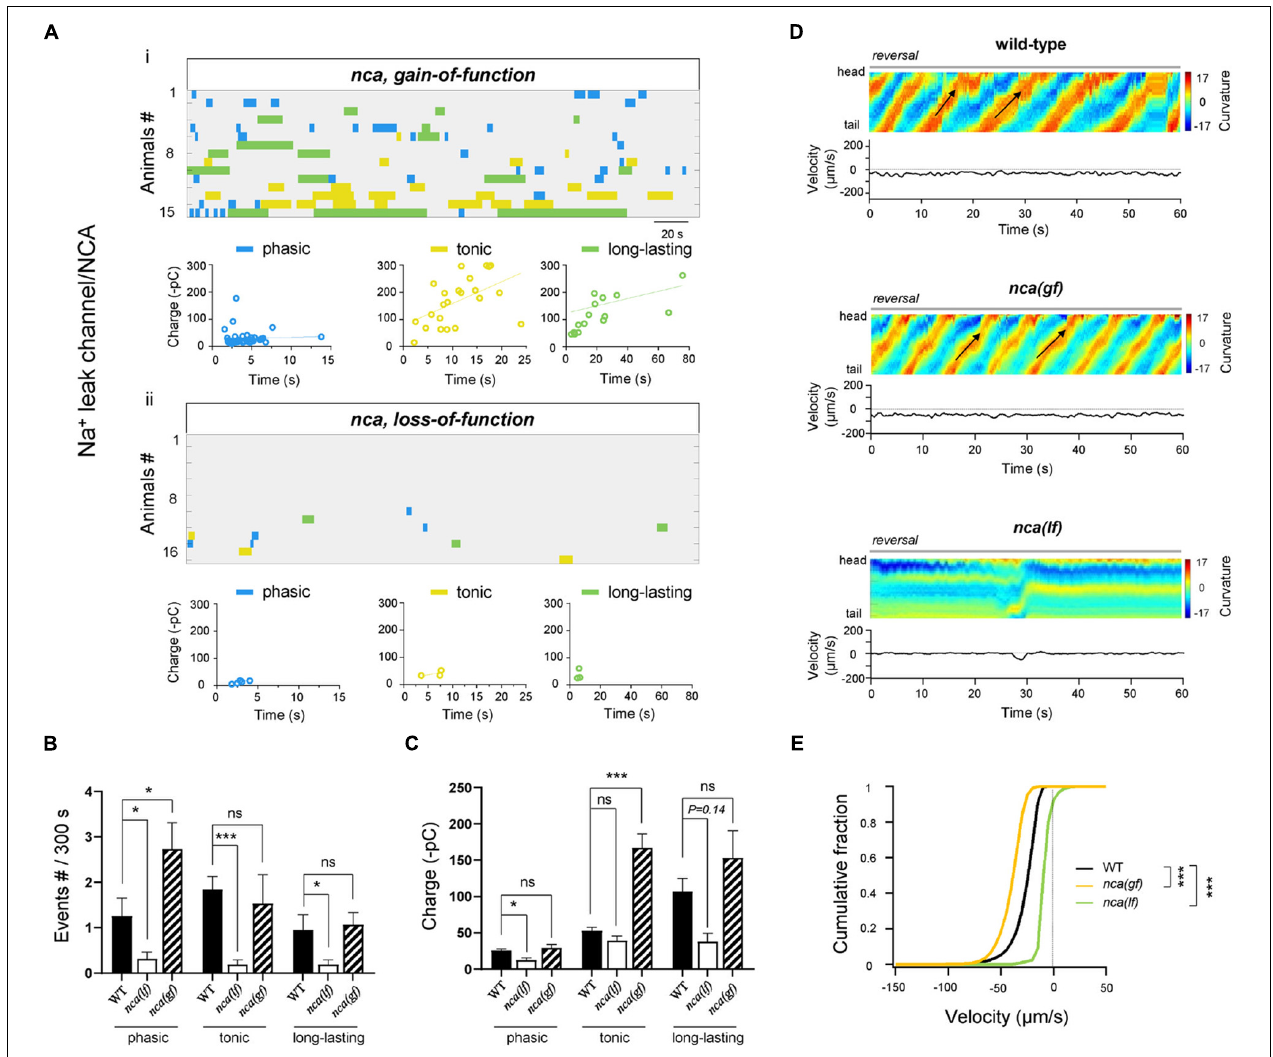
FIGURE 2 | NCA Na + leak channel is required for all types of rPSCs. (A) Colormap and charge efficiency (linear fitting) of all rPSC events recorded from ablated nca-1(hp102; gf) and nca-1(gk9; lf); nca-2(gk5; lf) mutant animals, respectively. Blue dots denote phasic-type events, yellow dots denote tonic-type events, and green dots denote long-lasting-type events. (B,C) Quantification of the frequency and charge of different rPSCs in respective genotypes. n ≥ 15 animals in each group. (D) Representative curvature kymogram ( up ) and instantaneous velocity ( bottom ) of free-behaving animals of respective genotypes after ablation. nca-1(hp102; gf) mutant animals exhibit increased reversal, as posterior to anterior propagating body bends (arrows), and nca-1(gk9; lf); nca-2(gk5; lf) mutants exhibit stalled backward. (E) Distribution of instantaneous velocity of wild-type, nca-1(hp102; gf) and nca-1(gk9; lf); nca-2(gk5; lf) mutant animals. The velocity fraction is left-shifted in the nca-1(hp102; gf) mutant, and right-shifted in the nca-1(gk9; lf); nca-2(gk5; lf) mutant, respectively. n ≥ 10 in each group. *** p < 0.001 against ablated wild-type by the Kolmogorov–Smirnov test. All data are expressed as means ± SEM. Student’s t -test was used (B,C) . Statistical significance is indicated as follows: ns, not significant, * p < 0.05, *** p < 0.001 in comparison with that as